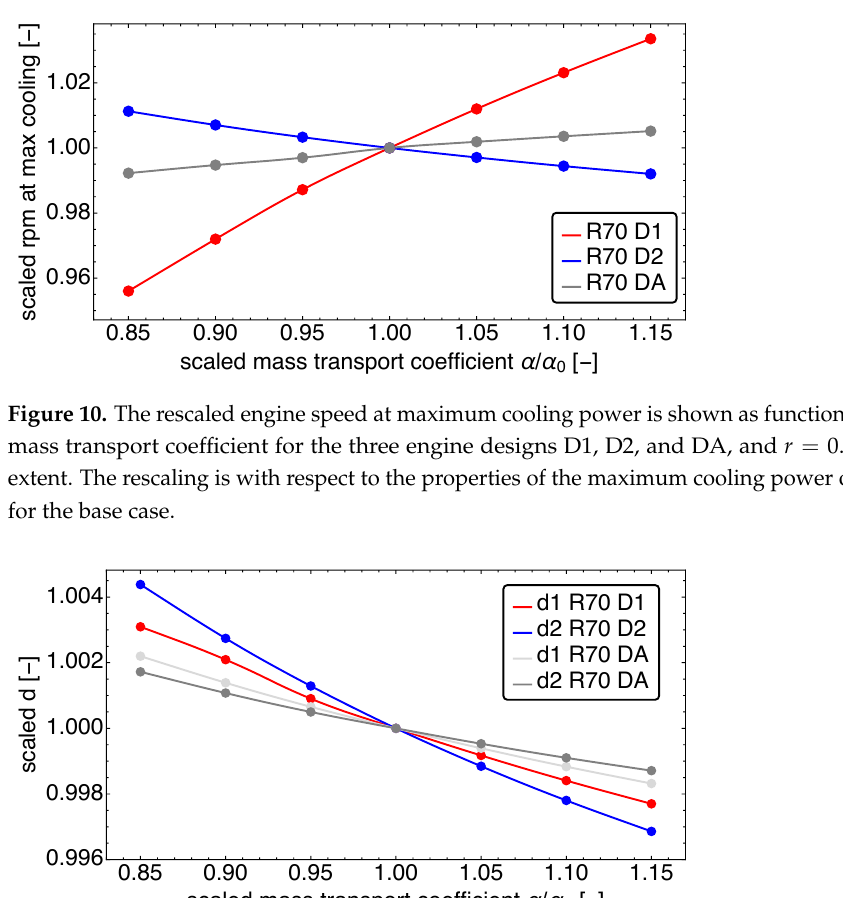
Figure 11. The rescaled displacement ratios d transport coefficient for the three engine designs D1, D2, and DA, and r = 0.7 regeneration extent. The rescaling is with respect to the properties of the maximum cooling power operating point for the base